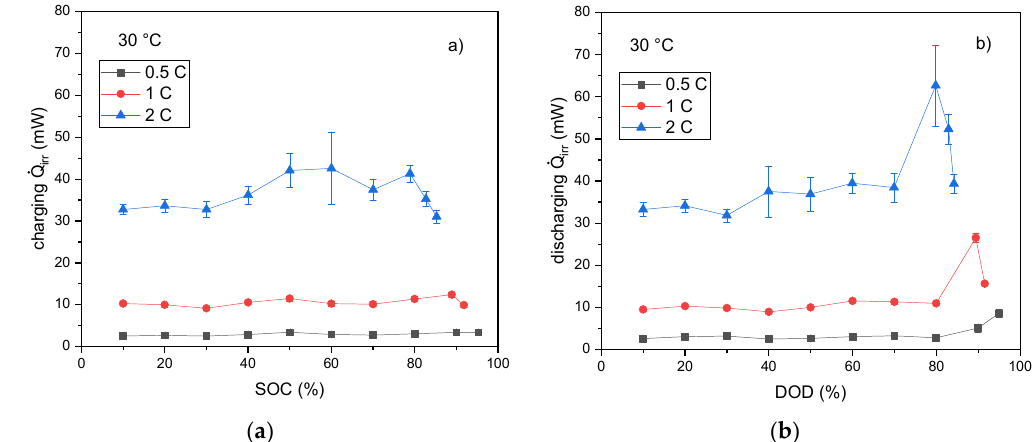
Figure 5. The total irreversible heat flow rates during charge ( a ) and discharge ( b ) with various C-rates versus SOC and DOD at 30 °C.